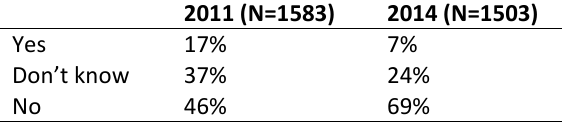
Table 1. Answers to the question “Are you willing to pay for online content?” in 2011 and 2014 among Estonian population (Sources: MeeMa database 2011,